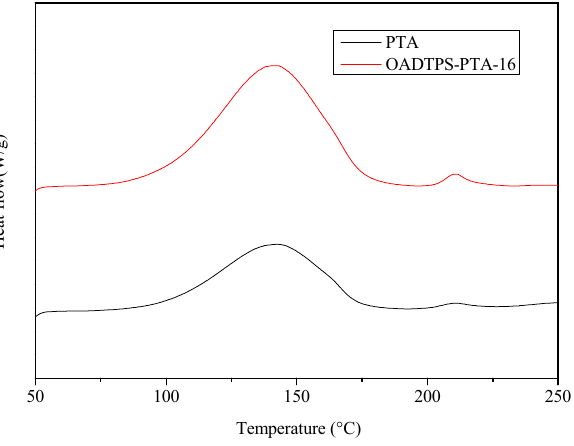
Figure 4: DSC curve of PTA and OADTP -